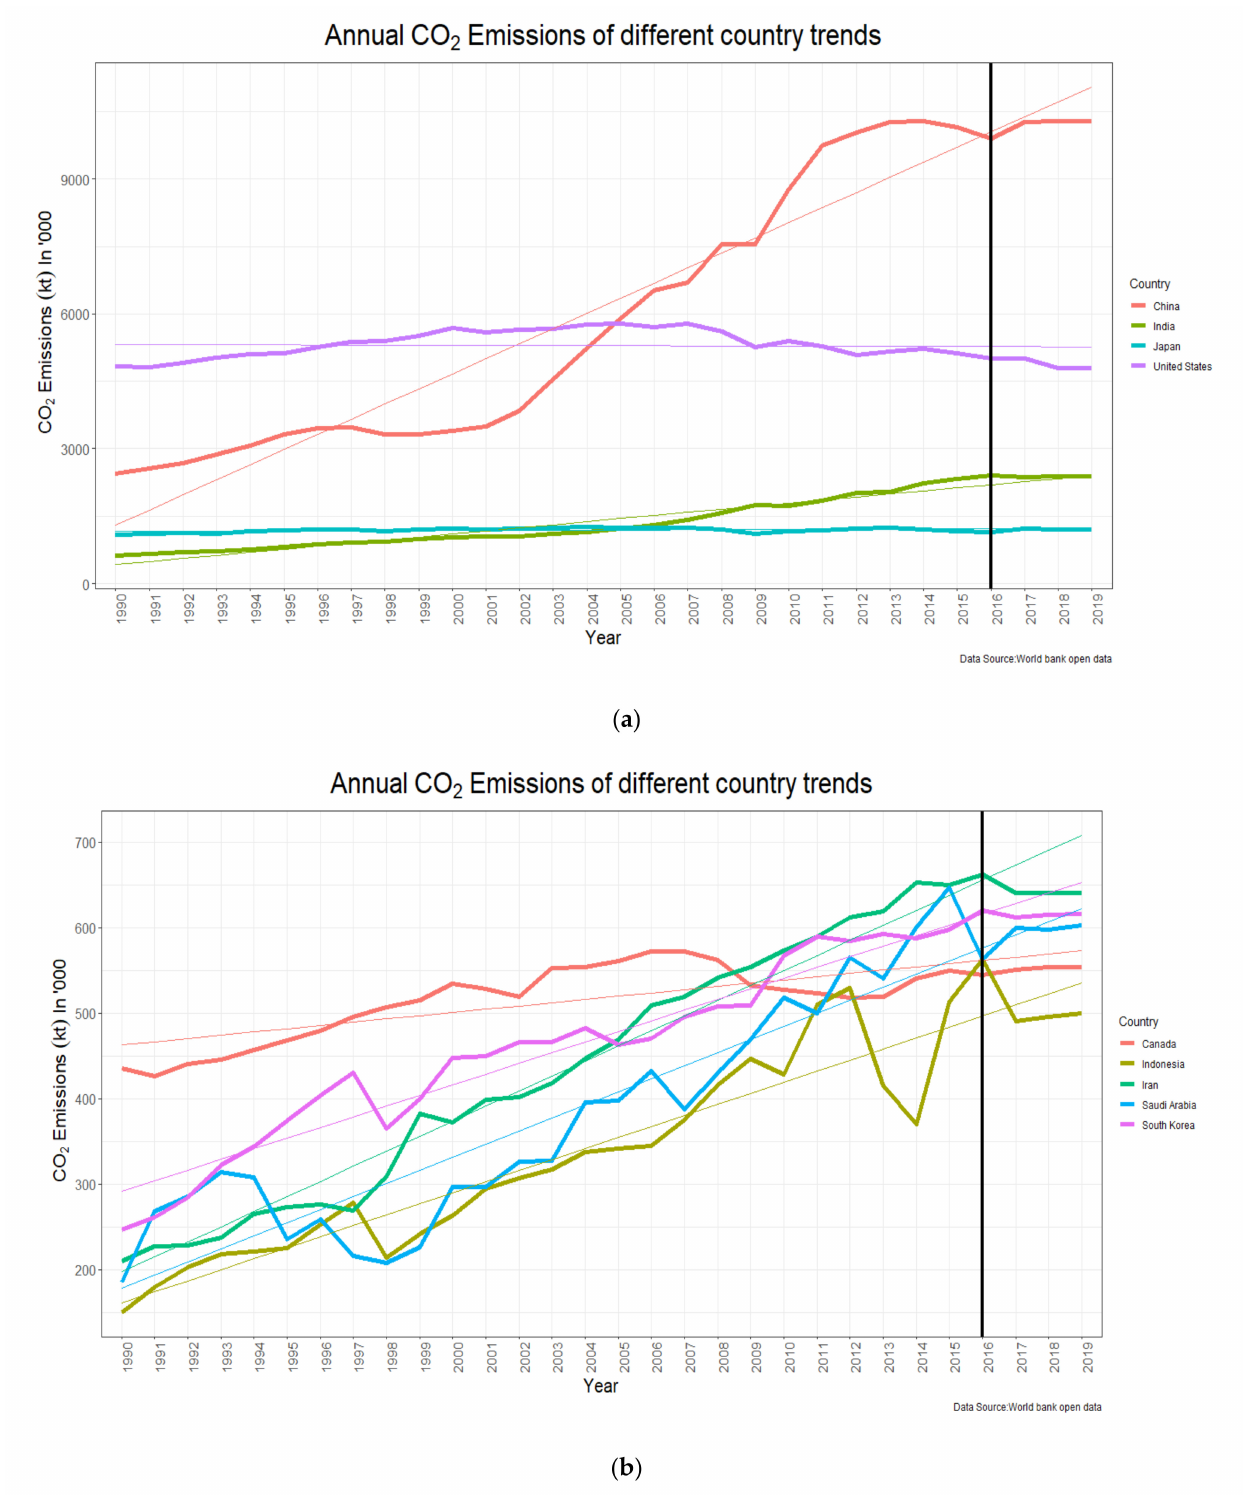
Figure 8. The actual and forecasted CO 2 emissions values for countries: ( a ) China, USA, India, and Japan; ( b ) Canada, Indonesia, Iran, Saudi Arabia, and South